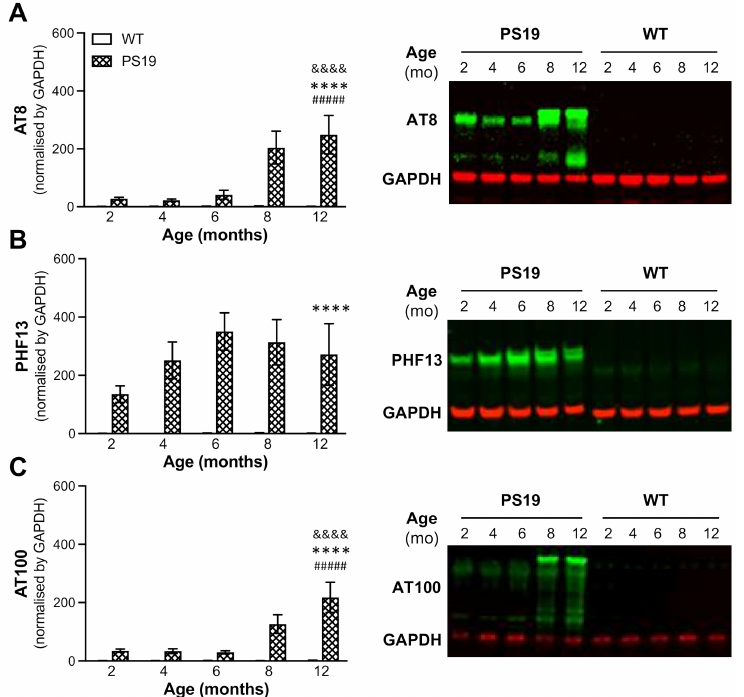
Figure 7. Mean ( ± SEM) protein levels of phosphorylated tau species Ser202/Thr205 (AT8; A ), Ser396 (PHF13; B ) and Thr212/Ser214 (AT100; C ) in the hippocampus of male wild-type (WT) and PS19 mice at 2, 4, 6, 8 and 12 months (mo) of age ( n = 11–15/genotype/age), with example immunoblots of AT8, PHF13, AT100 and GAPDH (data were normalised by GAPDH). &&&& indicates a significant genotype and age interaction at p < 0.0001. **** indicates a significant genotype effect at p < 0.0001. ##### indicates a significant age effect at p <